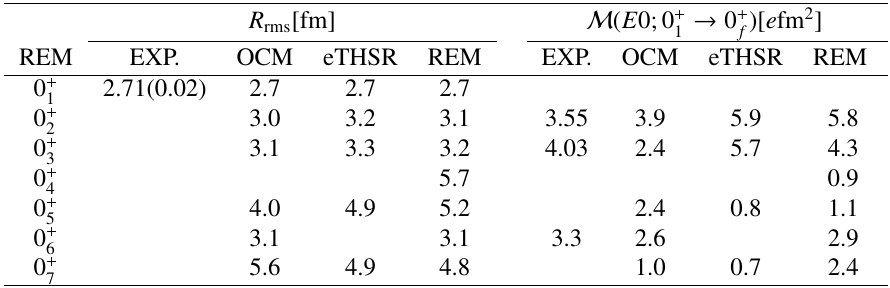
Table 2. r.m.s. charge radii R rms and monopole matrix elements from the ground state M ( E 0;0 + → 0 + ) of the experiment [7] and the 4 α OCM [1], eTHSR [2], and REM calculations in 16 O. f 1 R rms [fm] M ( E 0; 0 +